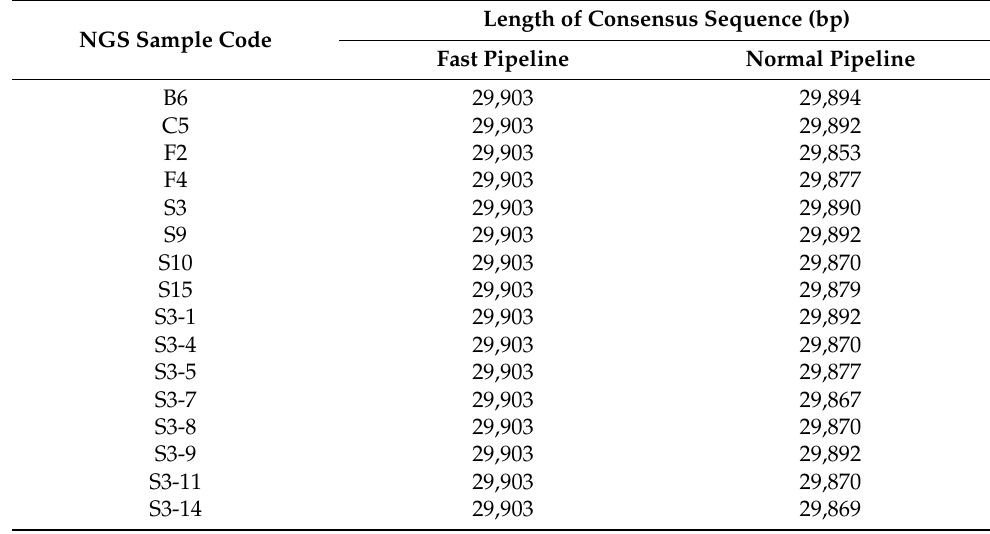
Table 11. Result of consensus sequences constructed by using a combination of SAMtools and BEDtools.